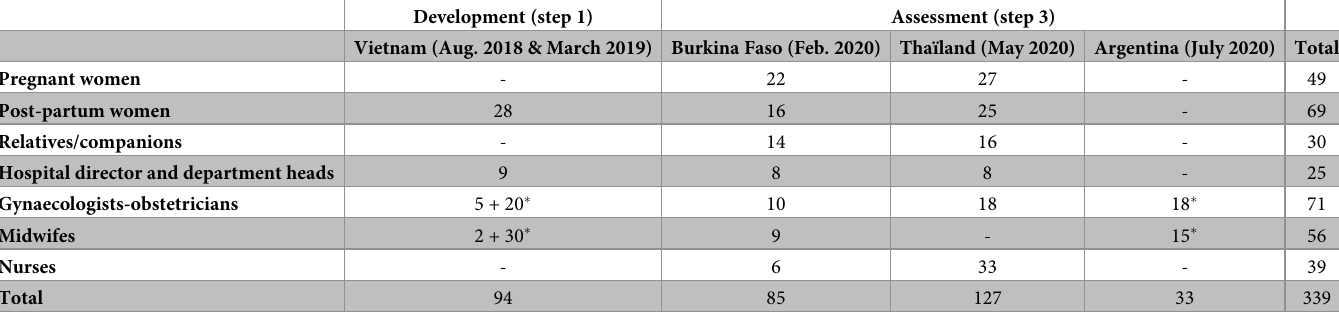
Table 2. Key informants for the development (step 1) and assessment of the decision-analysis tool (step